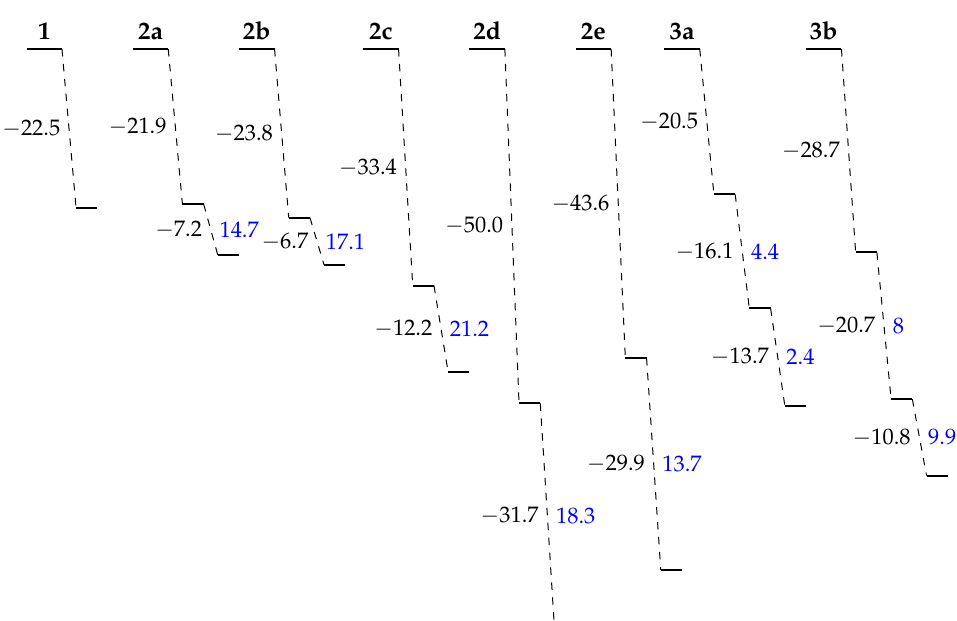
Figure 4. Average Gibbs free energy ( ∆ G 0 , i ∈ [ 1,3 ] , kJmol − 1 , computed as the sum of the energies i of the independent fragments) at 298.15K of the successive protonation reactions with trifluoroacetic acid (TFA) as a function of the level of opening. For the second (and third) openings, ∆∆ G 0 = ∆ G 0 − ∆ G 0 (kJmol − 1 ), being the difference between the current and previous ∆ G 0 , is also reported i i − 1 in blue. The calculations used the ω B97X-D/6-311G(d)/IEF-PCM (acetonitrile) level of theory for the BOXs and the ω B97X-D/6-311+G(d)/IEF-PCM (acetonitrile) level of theory for the TFA. For 3b , only the most spontaneous sequence of opening (Ph → PhTh → BiPh) is reported.